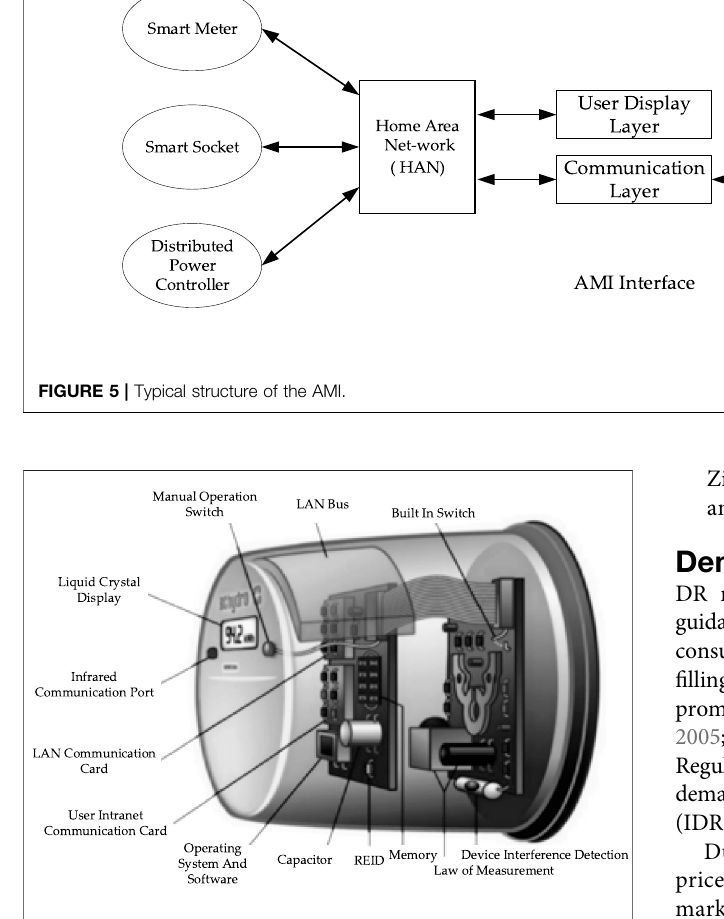
FIGURE 6 | Functional schematic diagram of a smart meter (Luan,